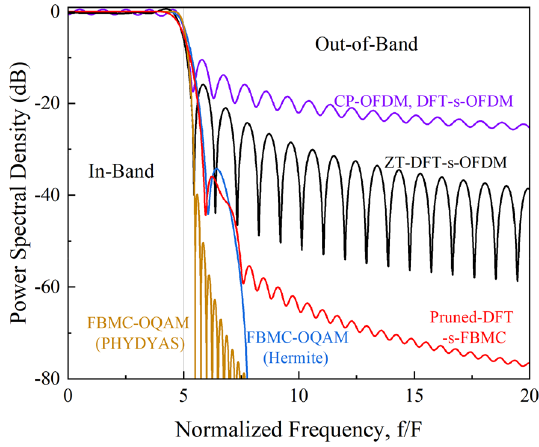
Figure 5. Simulated PSD of different multi-carrier signal waveforms.